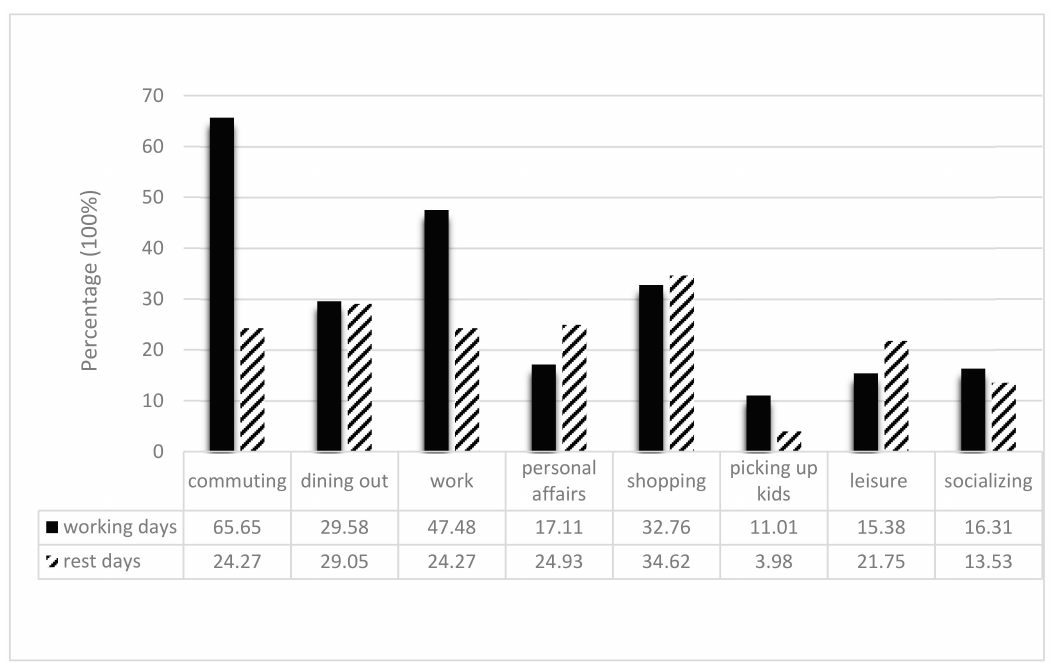
Figure 1. The percentage of different types of